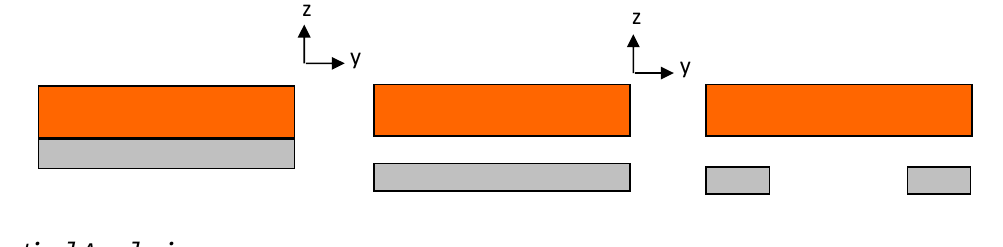
Figure 10. Section A-A of the energy harvester for the three cantilever designs.